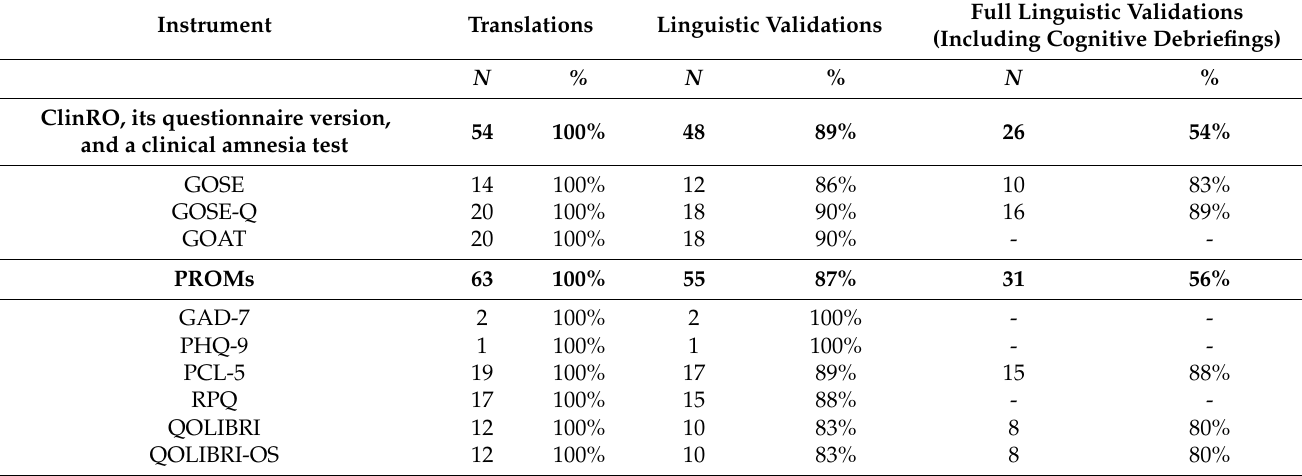
Table 4. Translations, linguistic and full linguistic validations for the instruments administered in the CENTER-TBI study.